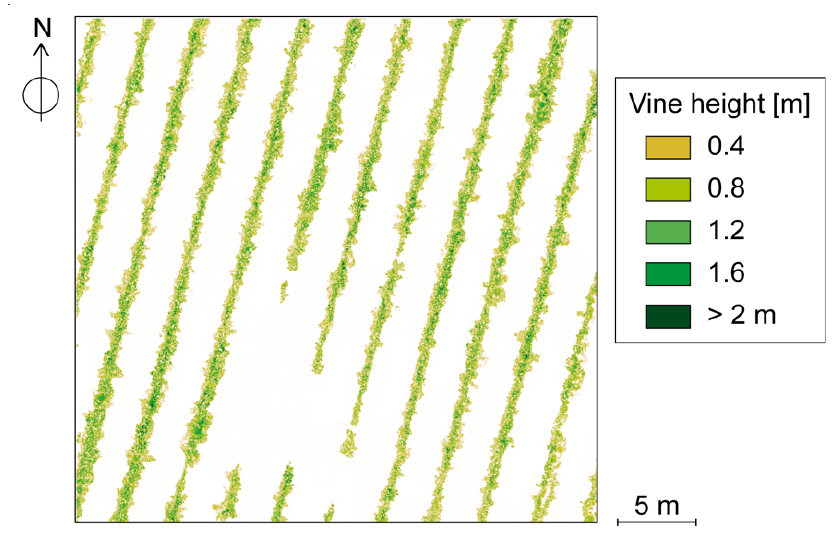
Figure 10. Example of a vineyard height-map based on the proposed methodology.